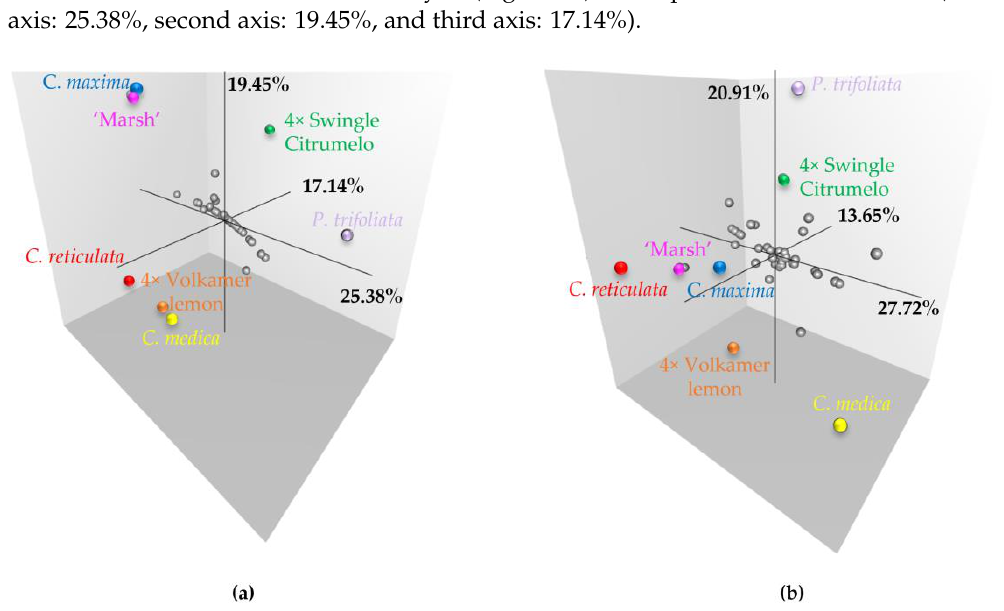
Figure 4. Factorial analysis based on a dissimilarity matrix established from ancestral doses along the genome for ( a ) chromosome 2 and ( b ) chromosome 5. Color dots represent parentage and grey dots represent the Volkamer lemon × Swingle citrumelo tetraploid hybrids.